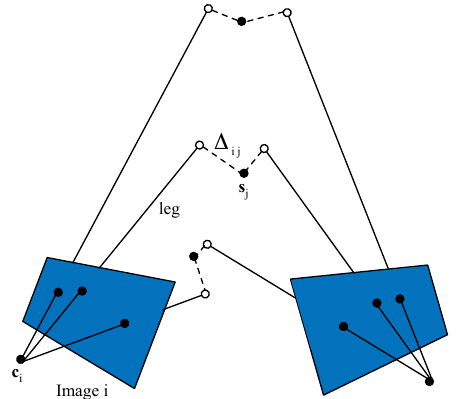
Figure 1. The “legs” are line segments emanating from image points. The Procrustean bundle adjustment optimizes camera orientation and the length of each leg so as to bring the legs’ endpoints as close as possible to each other, i.e., minimizing the length of the ∆ ij